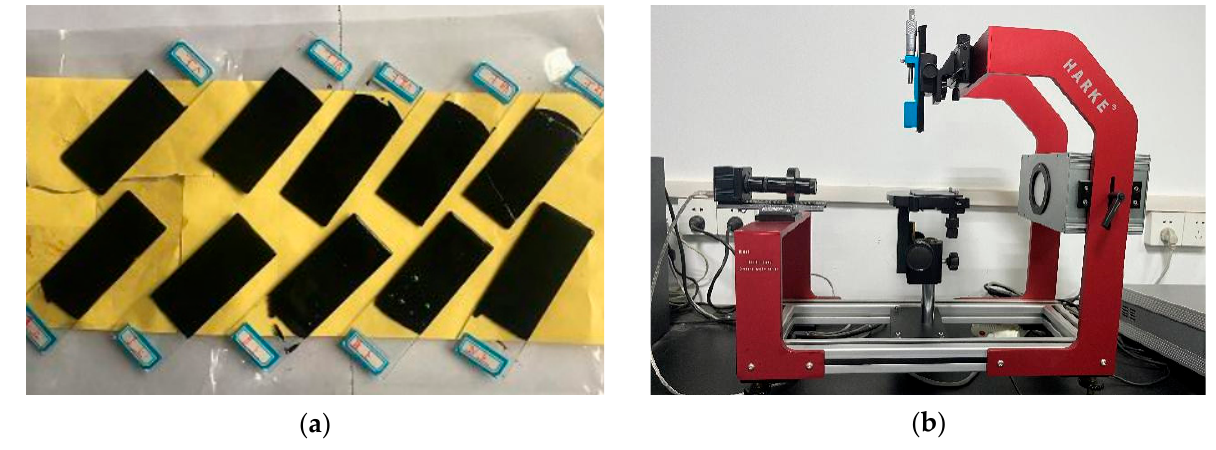
Figure 2. Asphalt film on glass slide ( a ) and contact-angle meter ( b ). The microstructure of PPW was tested by a DM2500 optical microscope (Leica, Wetzlar, Germany). FTIR spectra of PPW and asphalt binders were tested on the Tensor II spectrometer (Bruker, Germany). DSC measurements were performed on a DSC214 System-Instrument (Netzsch Company, Selb, Germany).